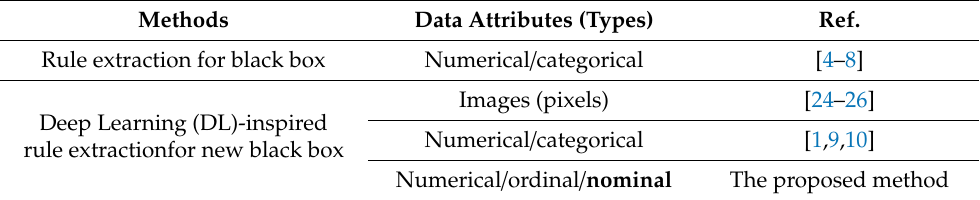
Table 1. Recent rule extraction methods for various data attributes